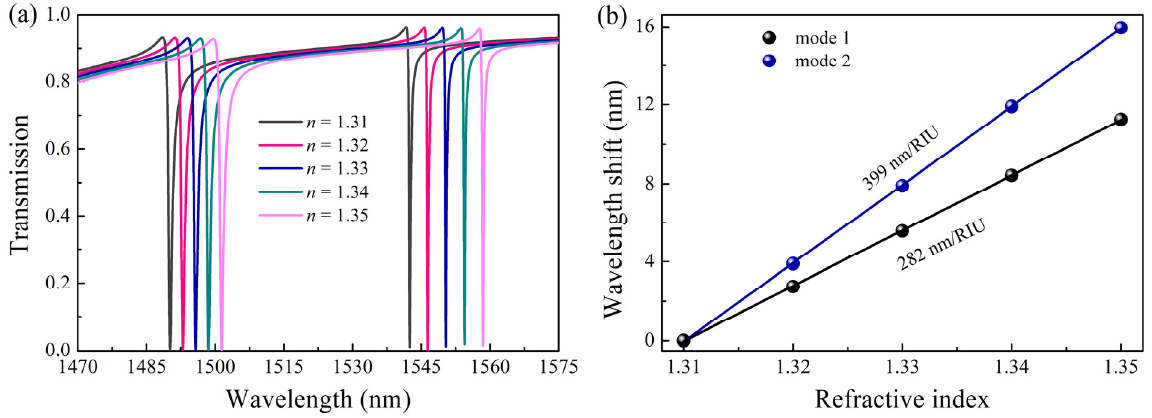
Figure 8. Analysis of sensing performance. ( a ) Variation of transmission spectra for different analyte’s refractive indices; ( b ) Refractive index sensitivity of resonance. Table 1. Comparison of sensitivity and FOM for various sensors.